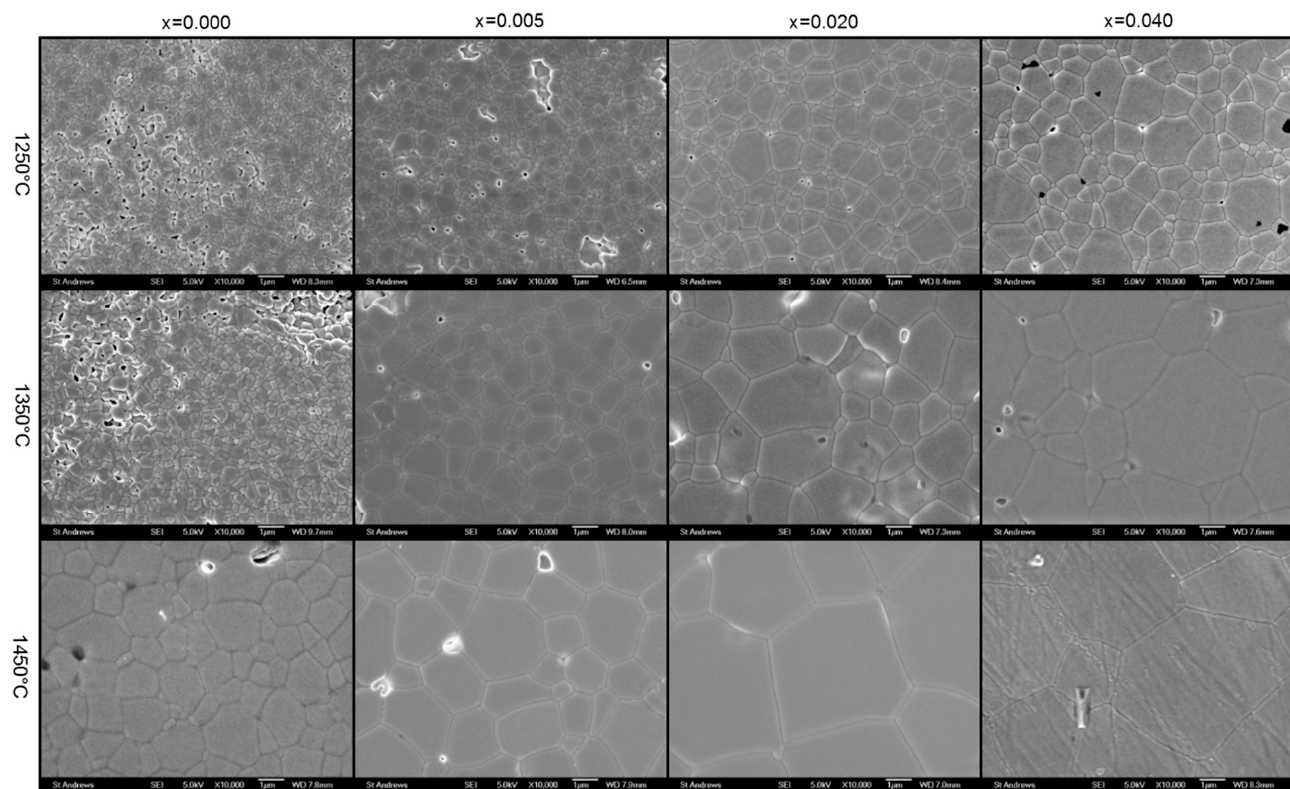
Figure 2. SEM micrographs of sintered and thermally etched samples of Sr00, Sr05, Sr20 and Sr40 (x = 0, 0.005, 0.020, 0.040, respectively, in Ce 0.8-x Sm 0.2 Sr x O 2- δ ) sintered at 1250 °C, 1350 °C and 1450 °C for 4 h, as indicated.